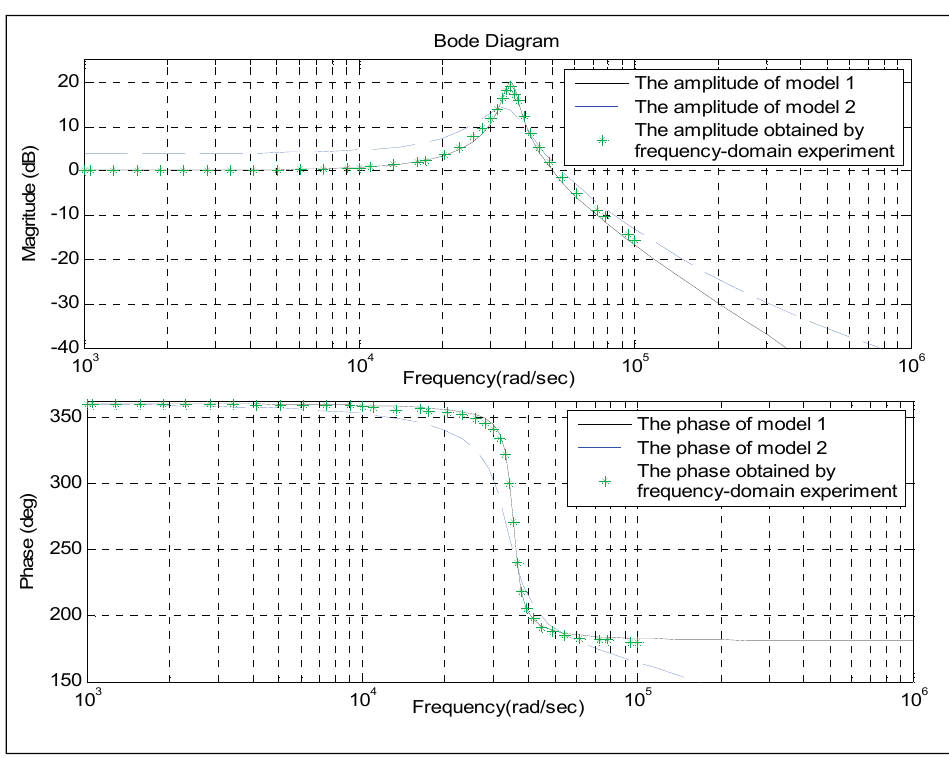
Figure 13. Frequency-domain characteristic data obtained by different